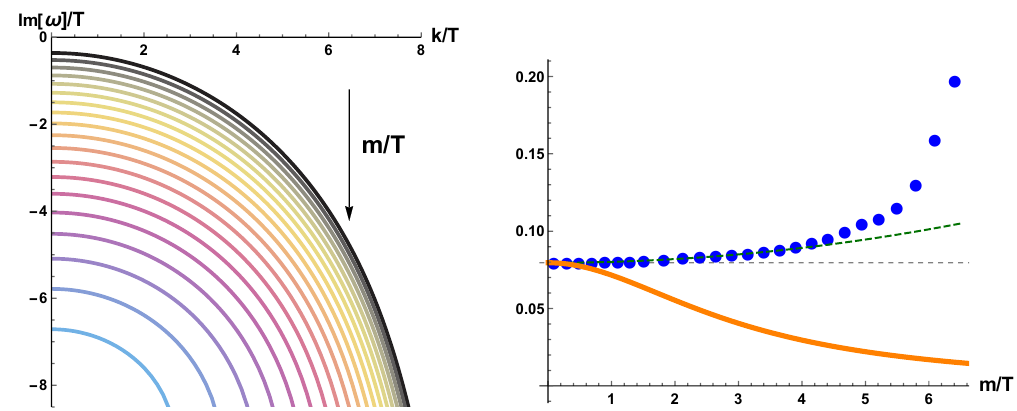
Figure 2: The dynamics of the shear mode in the simple ” linear axions model ” corre- sponding to V ( X ) = X . Left: The dispersion relation of the pseudo-diffusive mode ω = − i Γ − iD k 2 for m / T ∈ [ 1,6.5 ] (from black to light blue). Right: In orange T the viscosity to entropy ratio η/ s , in blue the dimensionless shear diffusion constant D T obtained numerically and in green the analytic formula (28). The horizontal T dashed value is 1 / 4 π